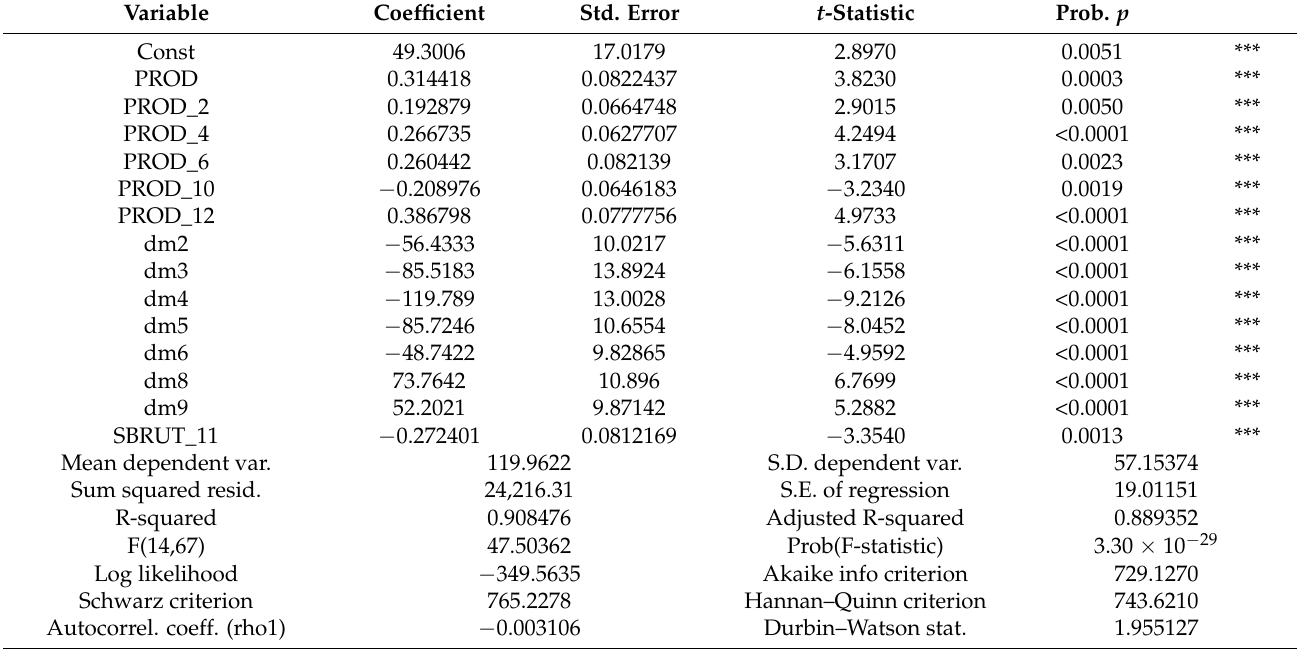
Table 3. Dependent variable: SBRUT t ; observations used 1997:03–2003:12 (N = 82).